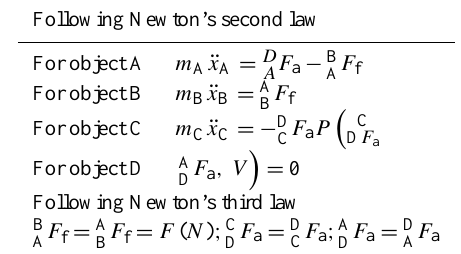
Table 1. General model of a PIFA. Following Newton’s second